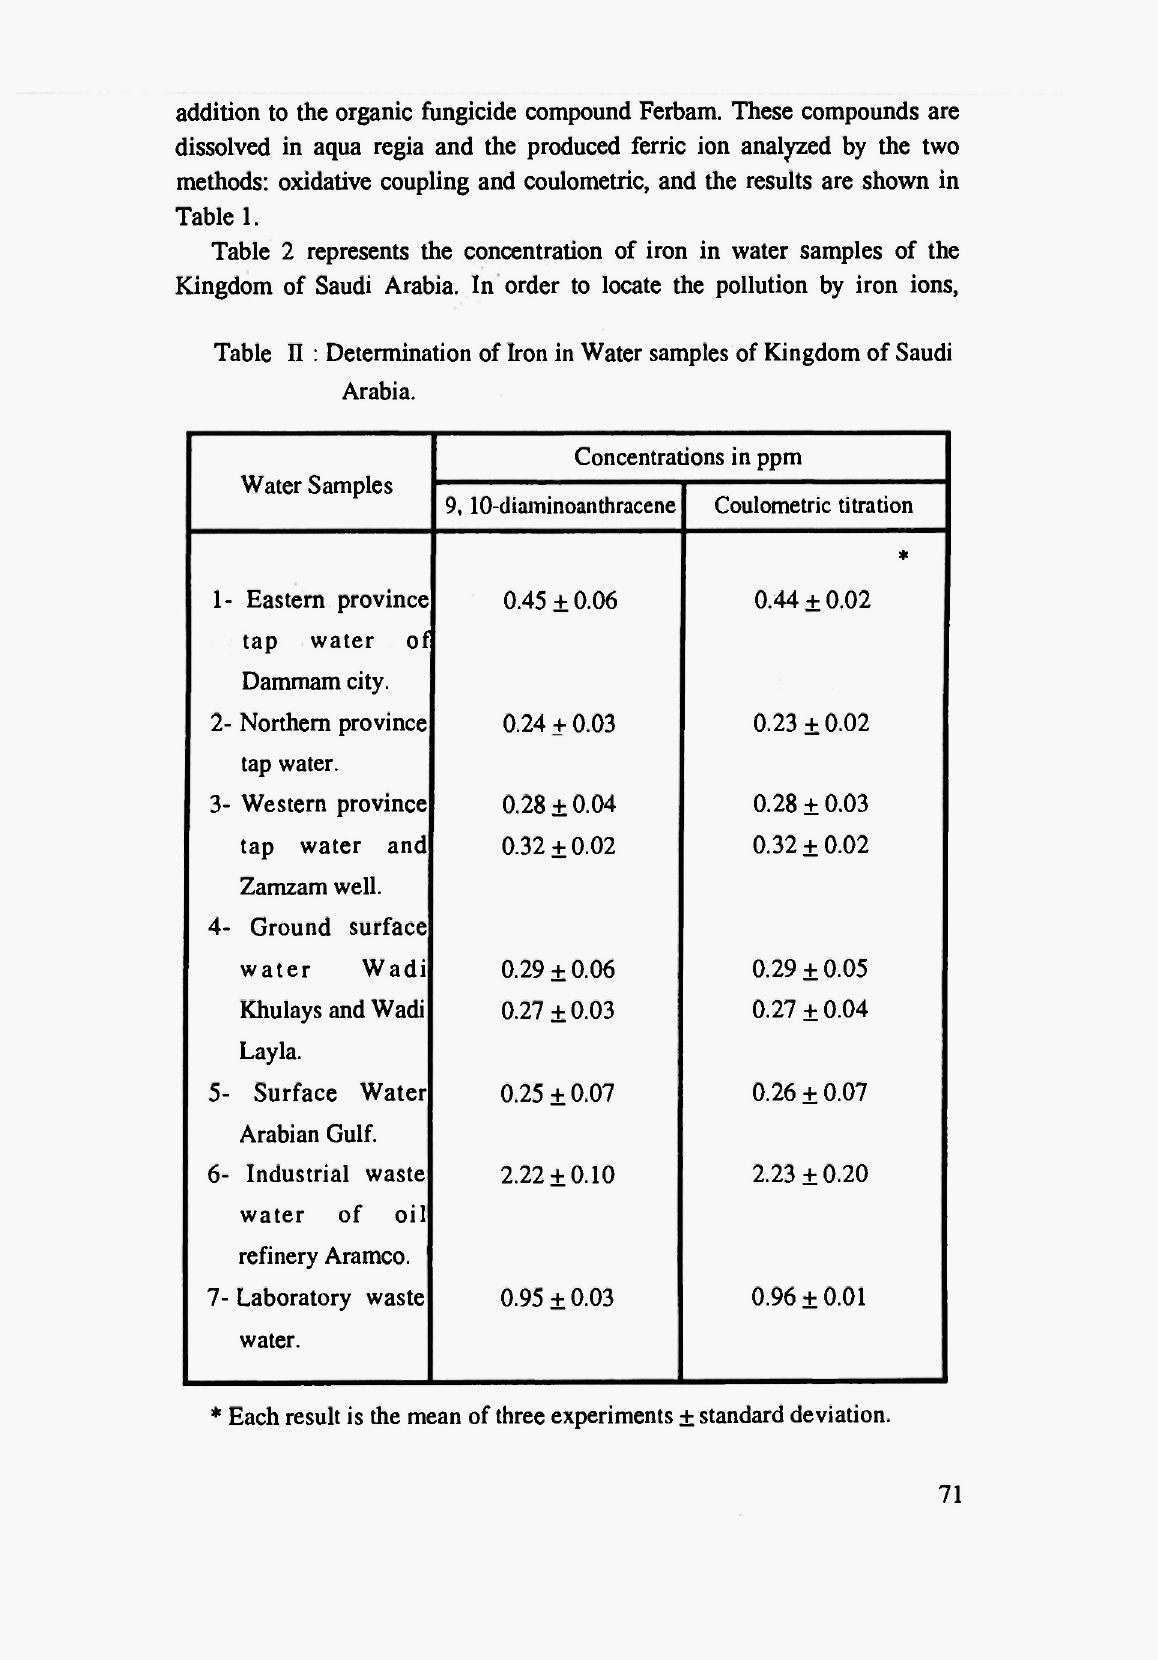
Table 2 represents the concentration of iron in water samples of the Kingdom of Saudi Arabia. In order to locate the pollution by iron ions, Table Π : Determination of Iron in Water samples of Kingdom of Saudi